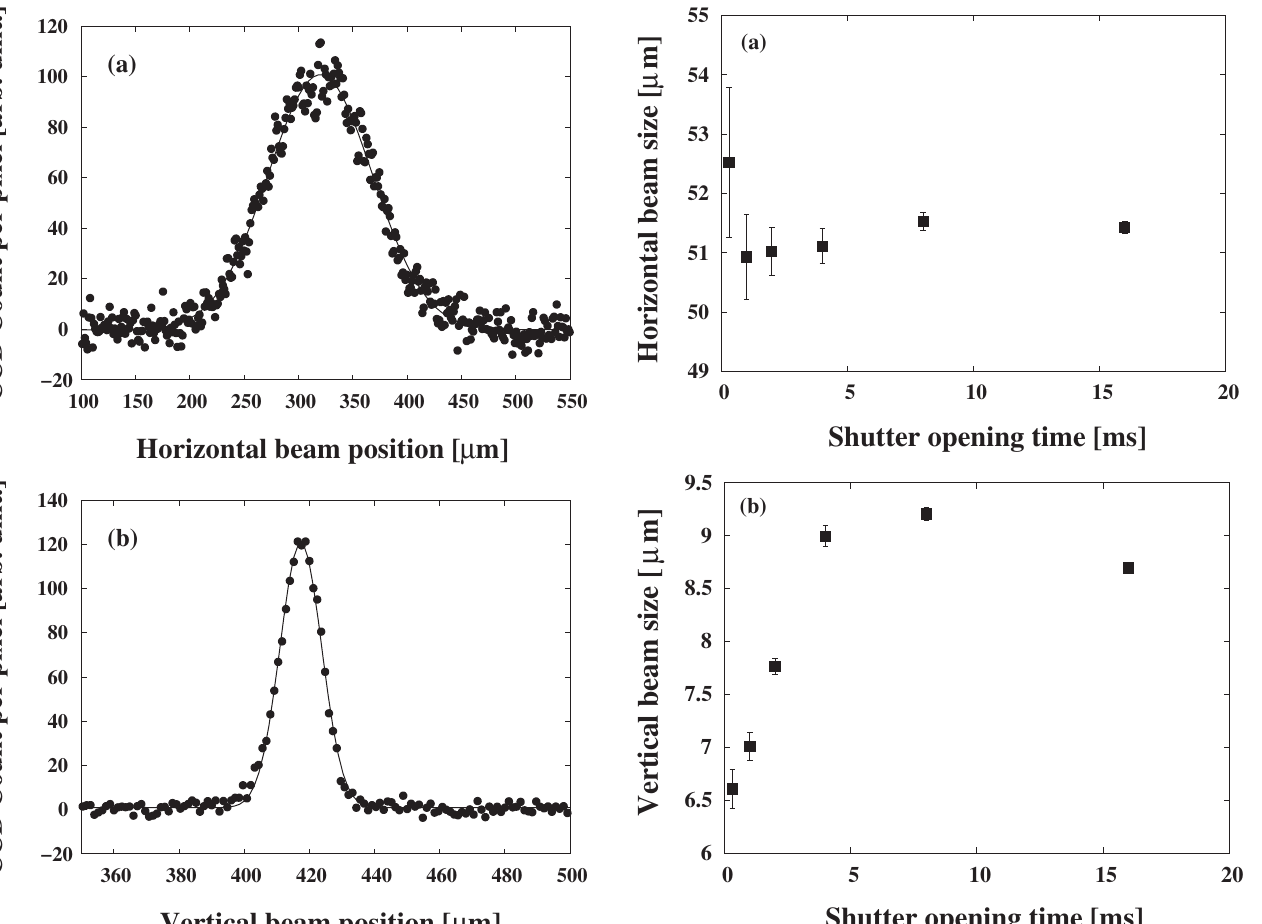
FIG. 12. Solid squares showing the measurement of the (a) horizontal and (b) vertical beam sizes as a function of the shutter opening time. The beam current was fixed at 4 mA in a single- bunch mode. Data are from 2005 = 4 = 8